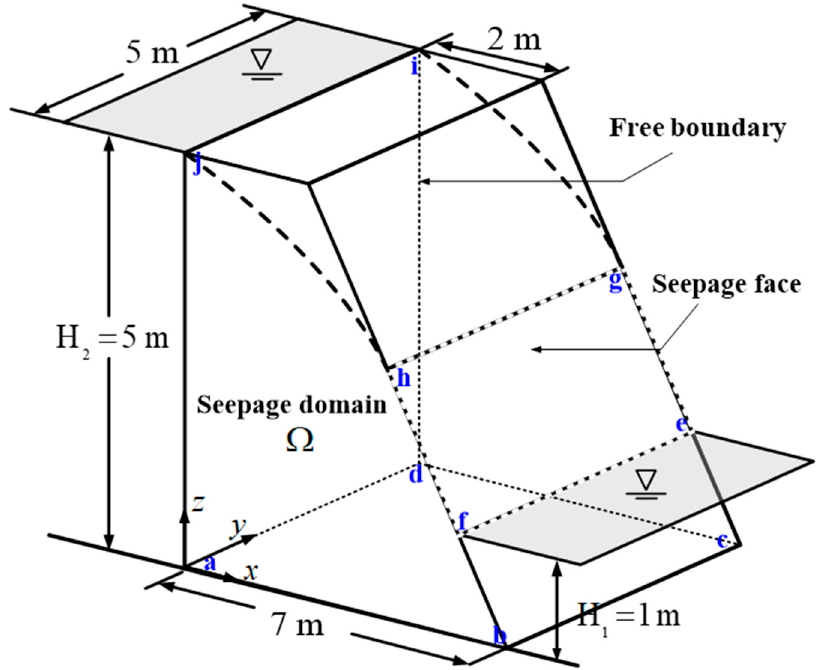
Figure 14. Flow through a trapezoidal dam in three dimensions.